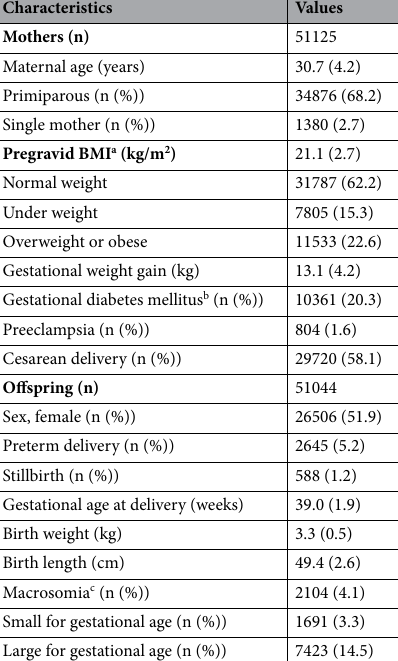
Table 1. General characteristics of the study participants Values are means (SD) or frequencies. a Pregravid body mass index, categorized by WHO Asian 29 . b Diagnosed by IADPSG criteria 37